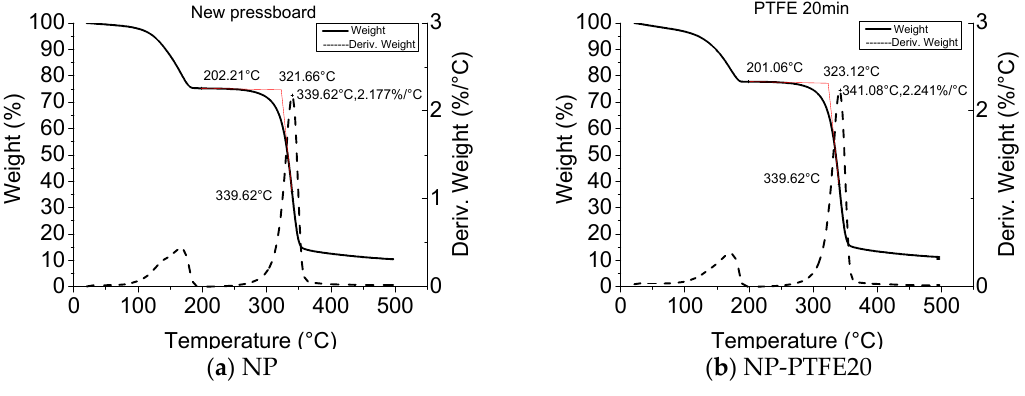
Figure 16. TG for NP and NP-PTFE20.